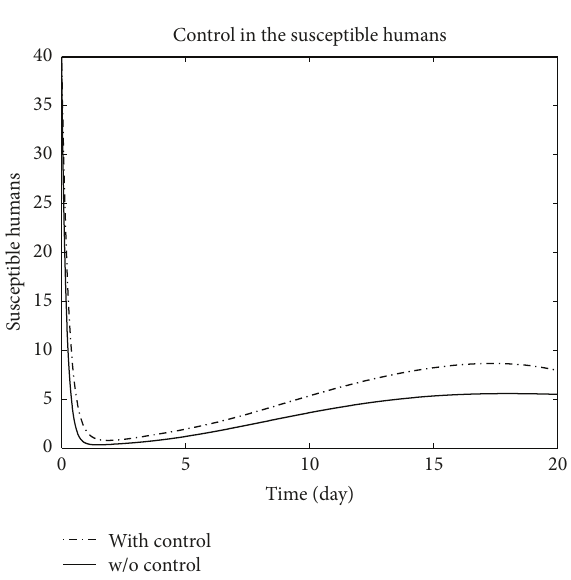
Figure 1: The plot represents the population of susceptible humans with and without